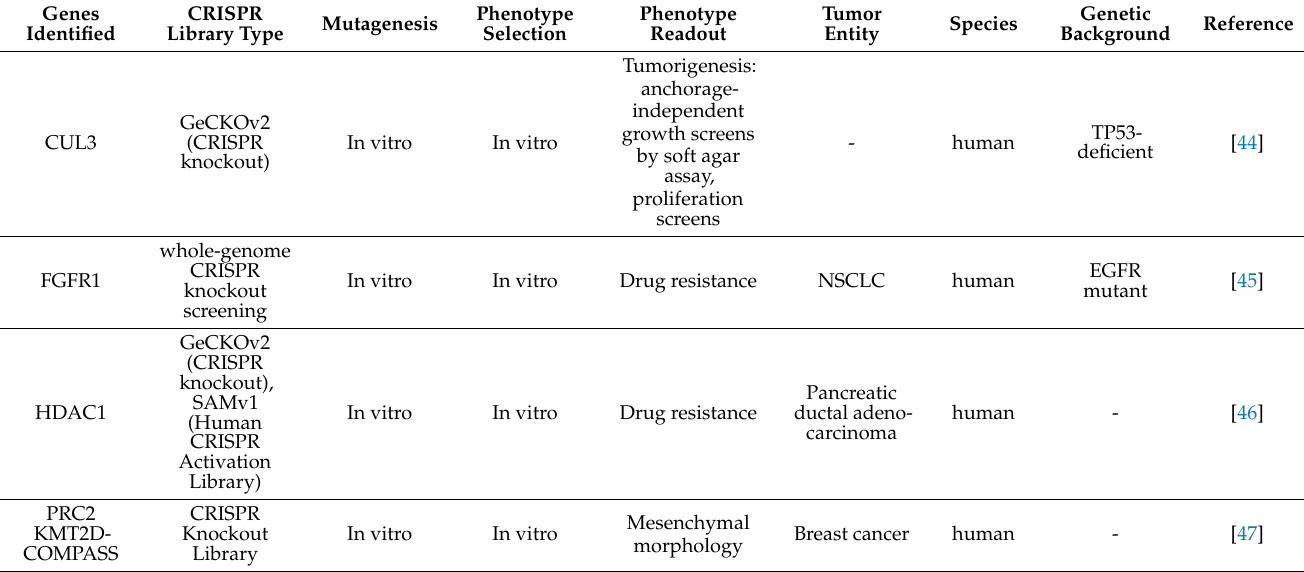
Table 2. Genome-wide CRISPR-based forward genetic screens identifying the roles of EMT and EMT